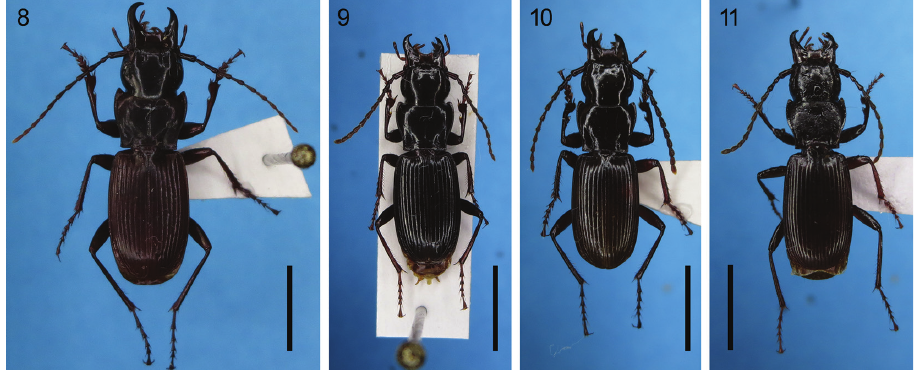
Figures 8–11. Dorsal view of species of the macrogenys species group. 8 Pterostichus shinbodakensis sp. n., holotype male 9 A female of the unidentified species sympatric with P. shinbodakensis 10 P. tateishiy- amanus sp. n., holotype male 11 P. tateishiyamanus sp. n., paratype female. All figures are of the same magnification. Scale bar = 5.0